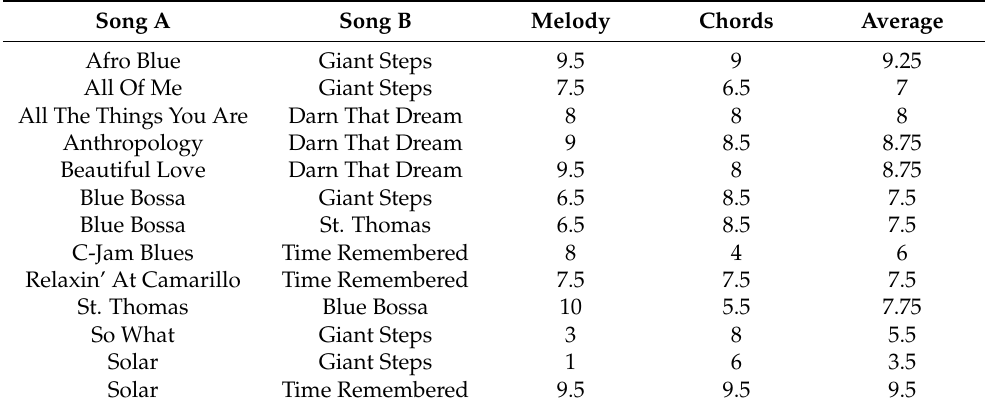
Table 4. Re-harmonization sessions and their ratings according to melody matching, selected chords and the average of the